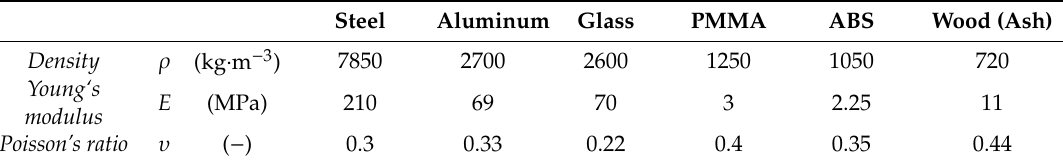
Table A1. Mechanical properties used in the DEM model.